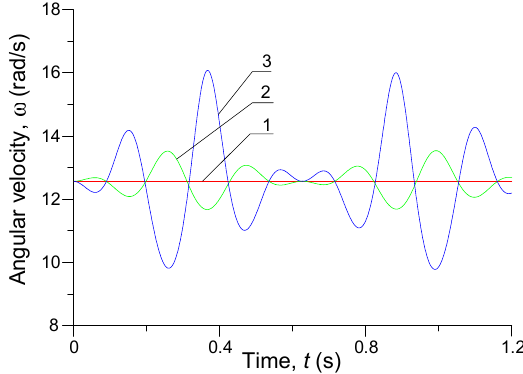
Figure 5. Angular velocity waveforms of three shafts: 1—first, 2—second, 3—third for the angles α 1,2 ≠ α 2,3 variable in time.